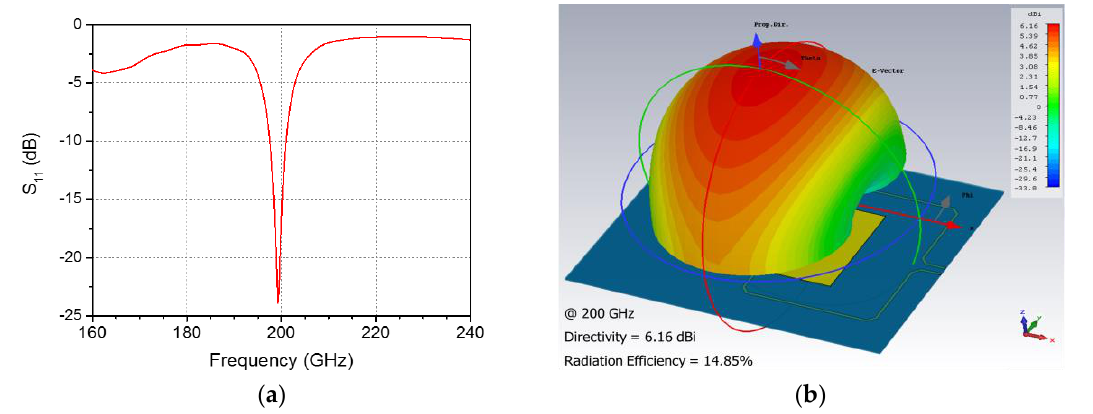
Figure 5. Simulation results of the integrated patch antenna: ( a ) S 11 and ( b ) the far-field radiation pattern at 0.2 THz.